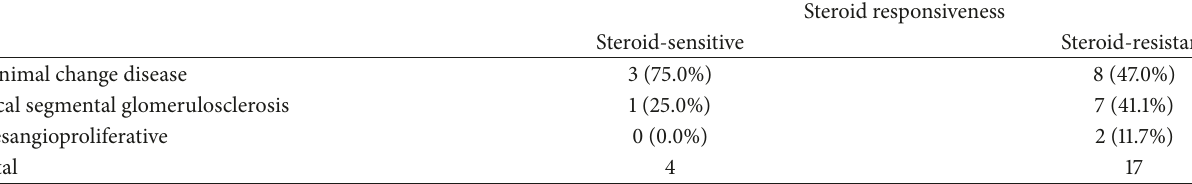
Table 3: Renal biopsy results of 21